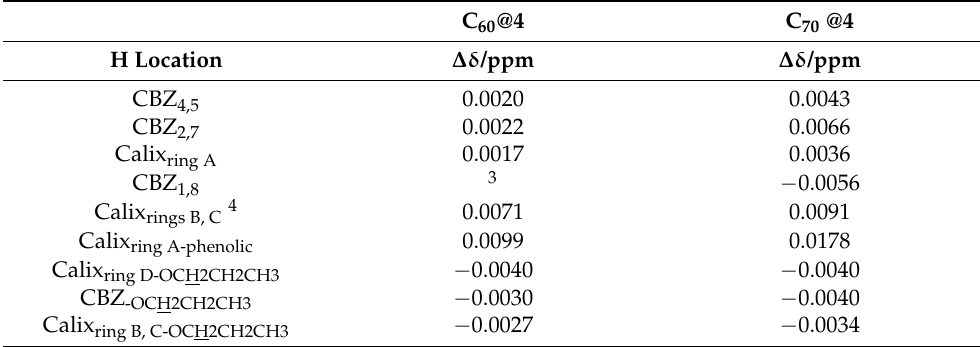
Table 3. Complexation-induced changes in the chemical shift (CIS) 1,2 of selected protons on 4 in toluene-d 8 solution. C 60 @4 C 70 @4 H Location ∆ δ